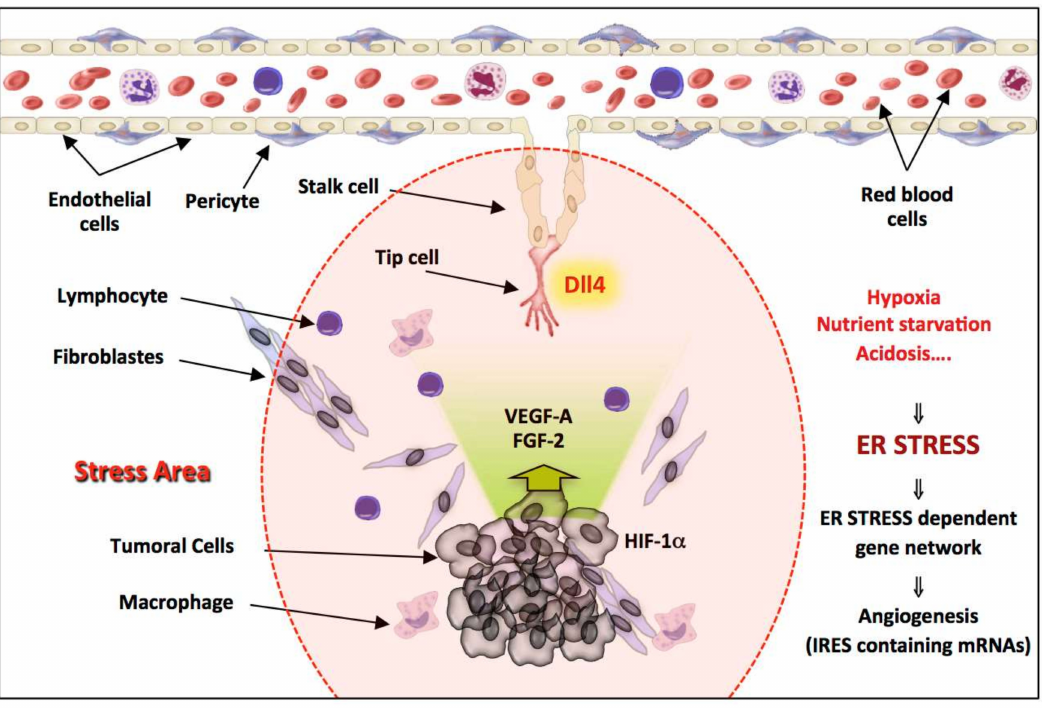
Figure 7. Schematic model of the network of gene expression co-regulation by stress during tumoral progression. During tumor progression, the stress zone encompasses the growing tumor, but also its microenvironment. The neo vessels and more particularly the Tip cells, present at the extremity and which guide the neo vessels towards the tumor, are located in this unfavorable microenvironment. Hypoxia, nutrient starvation and acidosis will irremediably induce the accumulation of unfolded protein in the reticulum of cells located in this area, leading to ER stress and UPR activation. Thus, in addition to transcriptional regulations, the activation of the PERK pathway will induce the co-regulation of an UPR dependent gene network containing IRES elements, revealing a translational regulon in which the synthesis of a cohort of angiogenic related genes is activated in response to ER stress. The fine-tuning of gene expression allows an efficient control of angiogenesis, which is a highly regulated